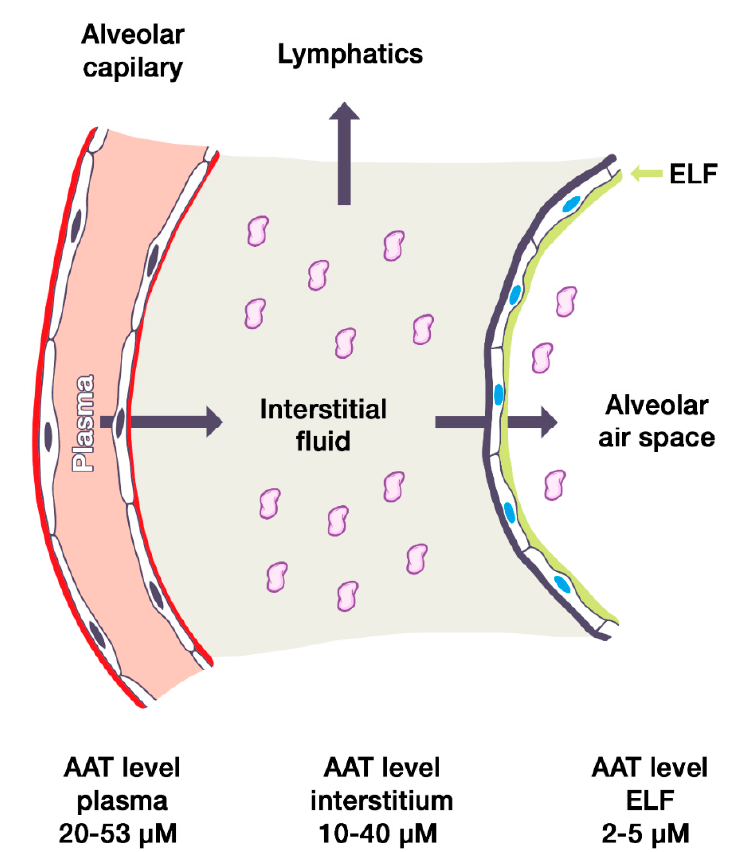
Figure 1. Diagram indicating alpha1 antitrypsin in plasma from normal individuals diffusing across the alveolar capillary endothelial barrier into the interstitium. AAT, Alpha1 antitrypsin; ELF, epithelial lining fluid. The sizes of the vascular, interstitial, and alveolar compartments are not to scale, for educational purposes.